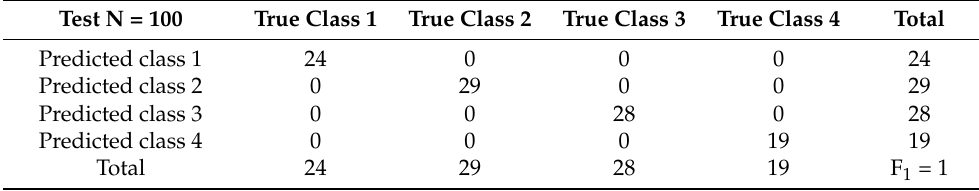
Table 1. Confusion matrix for predicting the four types of TRACE time series, with F 1